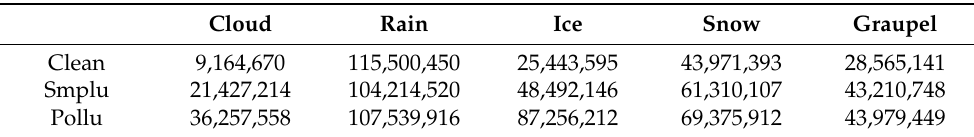
Table 1. Number of voxels of different types of hydrometeors sampled under clean, semi-polluted, and polluted